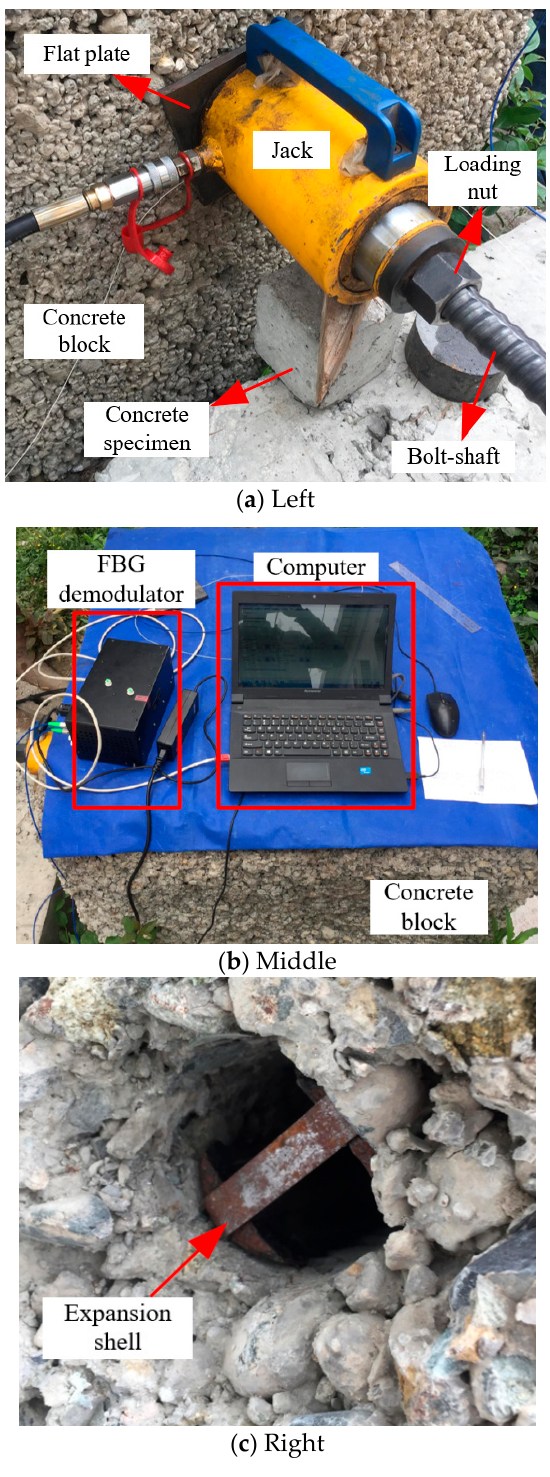
Figure 9. Schematic of the experiment.